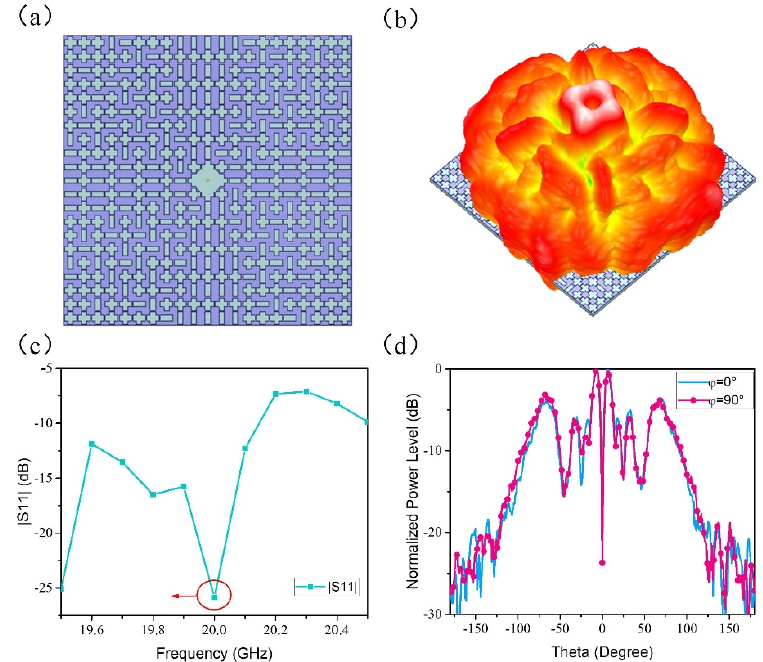
Figure 5. The simulated model of the proposed metasurface and its simulation results of radiation characteristics. ( a ) Top view of the proposed metasurface; ( b ) 3D radiation pattern; ( c ) reflection coefficient | S 11 | ; ( d ) and normalized power levels at planes of ϕ = 0 ◦ and ϕ = 90 ◦ , respectively.